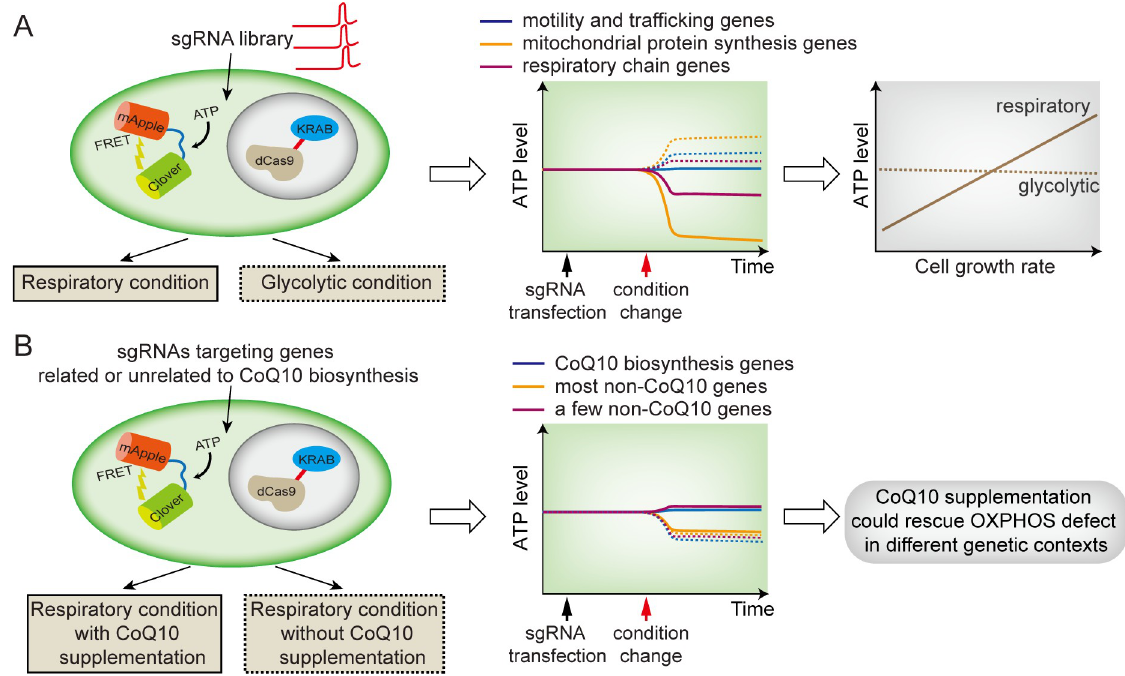
Fig 2. Combining real-time ATP biosensor with CRISPRi enables a single-cell–based high-throughput screening assay. (A) Assay design and results (schematics) [24]. (Left) Individual genes targeted by the sgRNA library were knocked down in cells expressing the improved ATP biosensor. Types of conditions are indicated by solid or dashed lines. (Middle) Gene knockdowns often result in opposite responses in cellular ATP levels for the respiratory versus the glycolytic condition. Experimentally, sgRNA-transfected cells were subjected to two different conditions, and the resulting effects on ATP level of different gene knockdowns were quantified. Here, types of genes are indicated by line colors, and solid or dashed lines indicate corresponding conditions on the left panel. (Right) The altered ATP levels affect cell-growth rates in a metabolic-context–dependent manner. Note that the ATP levels were not quantified in real time in the actual experiments. (B) The effects of CoQ10 supplementation (schematics) [24]. (Left) Screen design and screen conditions. Types of conditions are indicated by solid or dashed lines. (Middle) High CoQ10 supplementation can rescue respiratory ATP levels for both deficiencies in CoQ10 biosynthesis genes and a few non-CoQ10 biosynthesis-related genes. (Right) These results show that CoQ10 supplementation could rescue diverse mitochondrial respiration defects, suggesting its potential therapeutic applications in mitochondrial disorders. CoQ10, coenzyme Q10; CRISPR, clustered regularly interspaced short palindromic repeats; CRISPRi, CRISPR interference; OXPHOS, oxidative phosphorylation; sgRNA, single guide